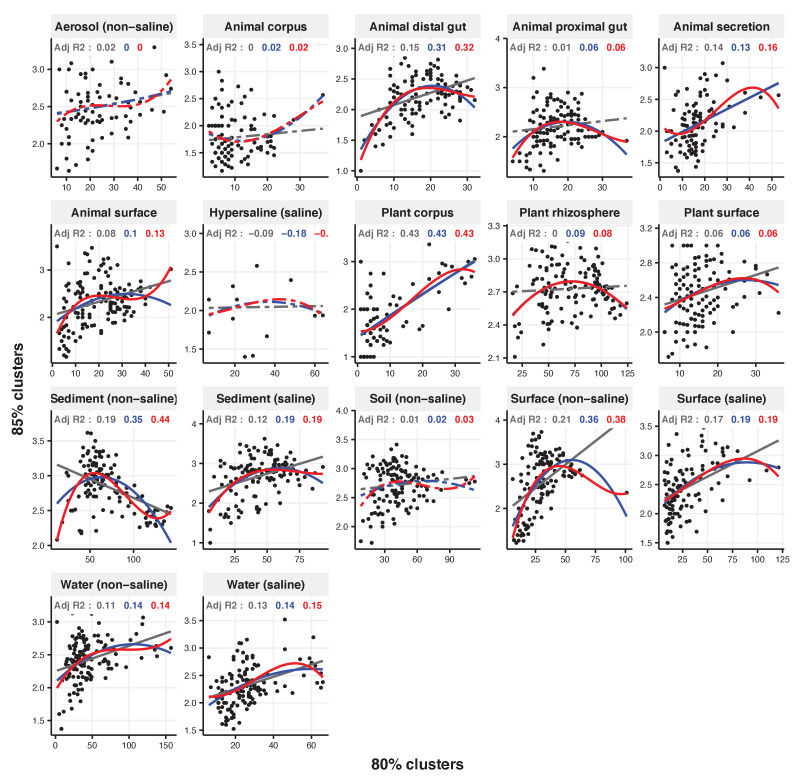
Focal clusters at 80% nucleotide identity.Community diversity was estimated as the number of clusters at a focal level (di) and focal lineage diversity as the mean of the clusters at the rank above (di 1/di). Linear (grey), quadratic (blue) and cubic (red), with corresponding adjusted R-squared values in the same colour. P-values are Bonferroni corrected for 17 tests. Significant, p<0.05 (solid lines), non-significant (dashed lines). The x-axis shows the number of clusters at the focal percent-identity level (di), and the y-axis is the mean of the clusters at the rank above (di 1/di).